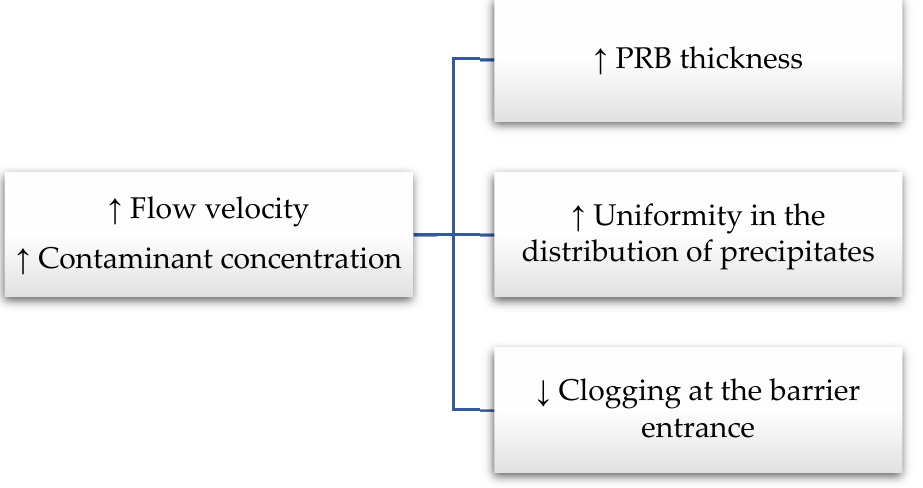
Figure 7. Flow chart showing the effects, for a given granular mixture composed of ZVI, of increasing the flow velocity or the concentration of contaminants.